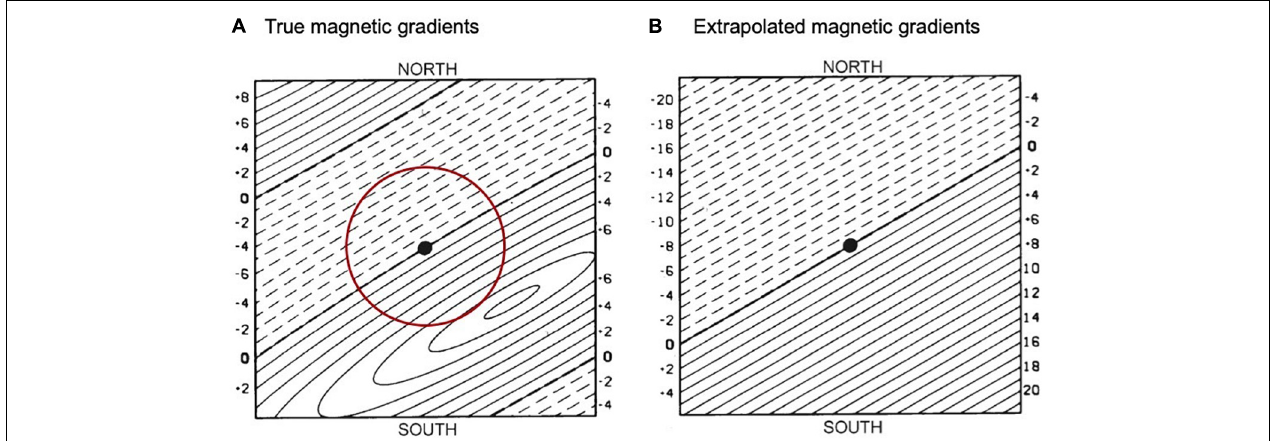
FIGURE 5 | An example of true and extrapolated magnetic gradients. A single gradient is showed for simplicity with positive (dashed line) and negative (solid line) values, on a scale over 1000 km. (A) True magnetic gradient values surrounding the individual’s home (black dot) and its familiar range (red circle). (B) The individual extrapolates gradients based on experience, and incorrectly anticipates the gradient in the northwest and southeast corners. Based on Wallraff